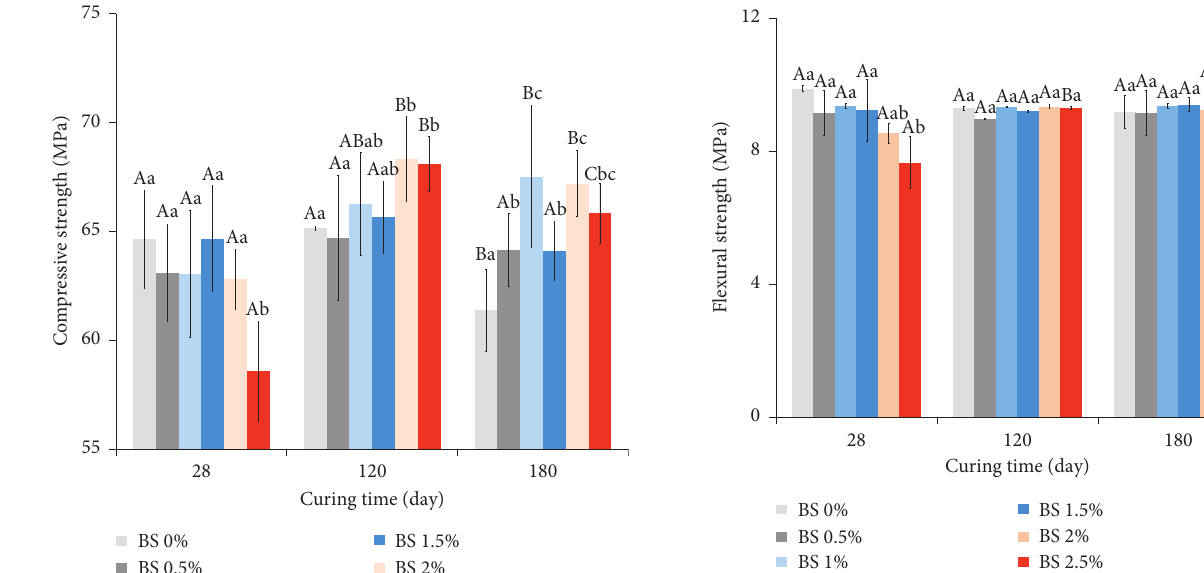
Figure 2: Effect of biosurfactant (BS) concentration on the flexural strength of mortars at curing periods of 28, 120, and 180 days. Tukey’s HSD test was performed to differentiate the significance of treatment. Statistically significant differences are noted by different letters. Capital letters indicate significant difference among curing times at the same biosurfactant concentration, and lowercase letters indicate significant differences among biosurfactant concentrations at the same curing